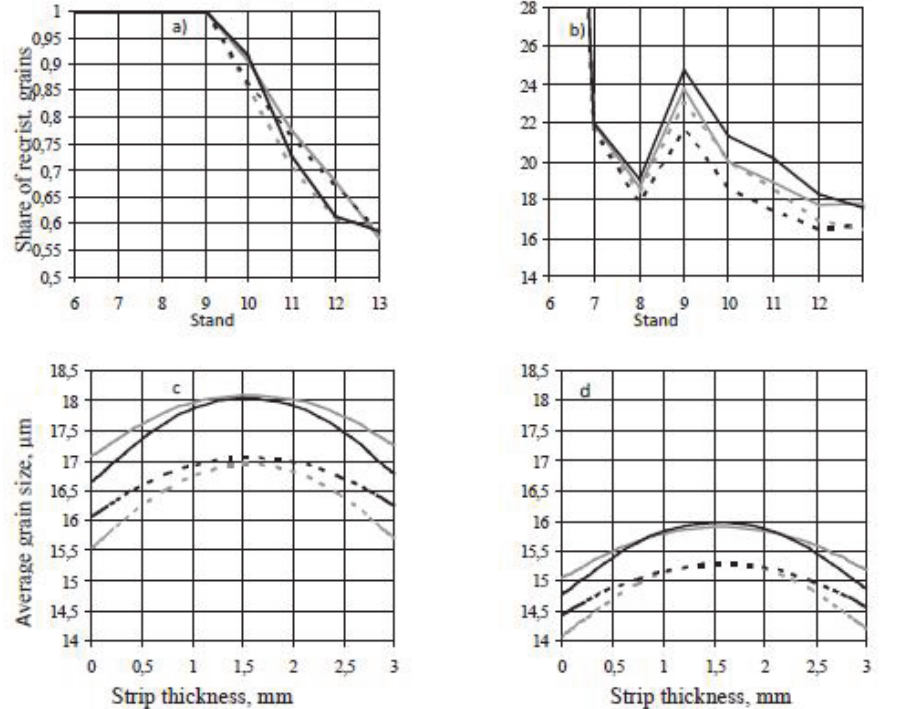
Figure 1: Comparison of the structural state of rolled strips using between standing